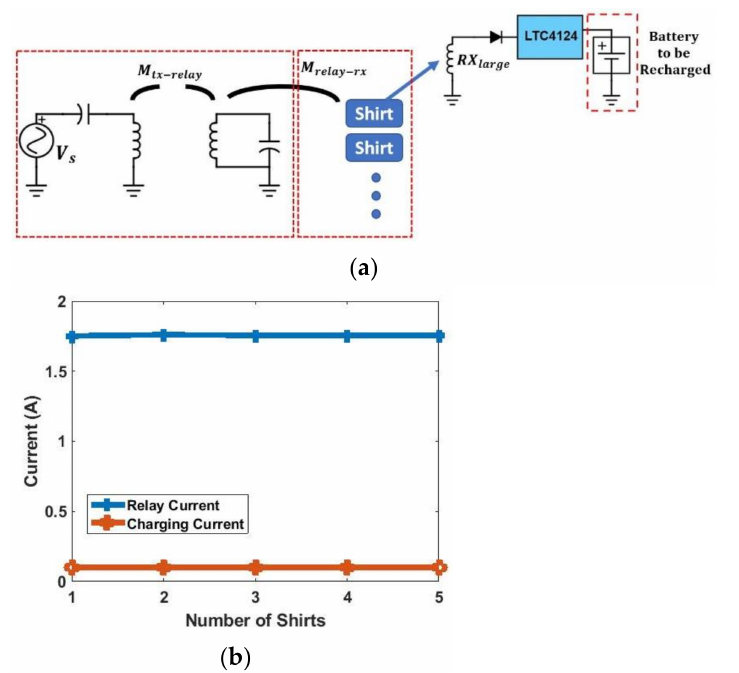
Figure 21. ( a ) Schematic of the wireless-charging drawer system with multiple shirts schematic; ( b ) LTspice simulation